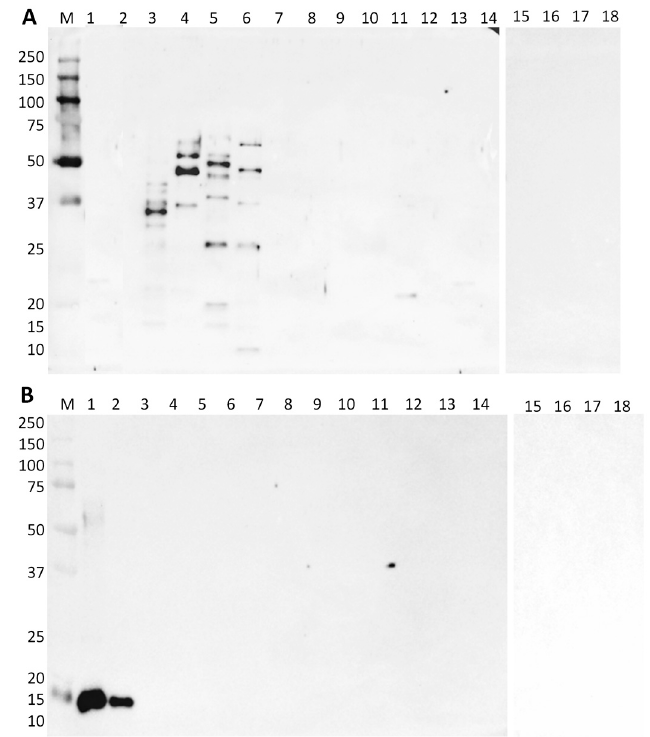
Figure 1. Immunoblot membranes using anti-gamma-conglutin polyclonal antibody ( A ) and anti-trypsin inhibitor polyclonal antibody ( B ) for the specificity test with different plant species. Legend: lane 1, soybean protein isolate (SPI); lane 2, soybean protein concentrate (SPC); lane 3, L. albus ; lane 4, L. luteus ; lane 5, L. mutabilis ; lane 6, L. angustifolius ; lane 7, rice; lane 8, wheat; lane 9, maize; lane 10, milk protein concentrate; lane 11, peanut; lane 12, walnut; lane 13, hazelnut; lane 14, fava bean; lane 15, chickpeas; lane 16,